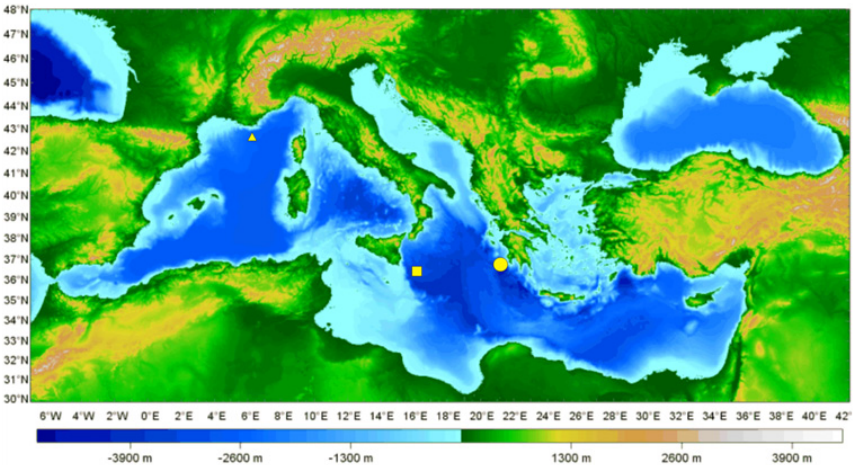
Fig. 5. Bathymetry of the Mediterranean sea with the site locations marked. Triangle marks the Toulon site, ANTARES Collaboration, (P. Amram et al., 2003), the square the Capo Passero site, NEMO Collaboration, (NEMO coll. , 2002) and the circle contains four possible sites near Pylos, NESTOR Collaboration, (E. Trimonis et al., 1992).